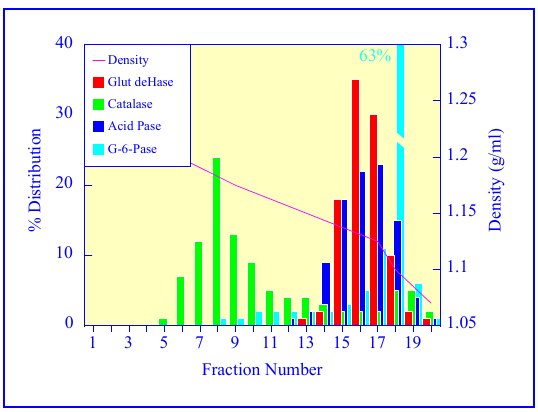
FIGURE 1 . Isolation of peroxisomes: enzyme distribution in gradient. Glut deHase = glutamate dehydrogenase, Acid Pase = acid phosphatase; G-6-Pase = glucose-6-phosphatase. Adapted from Ref. [4] with kind permission of Academic Press and the authors.